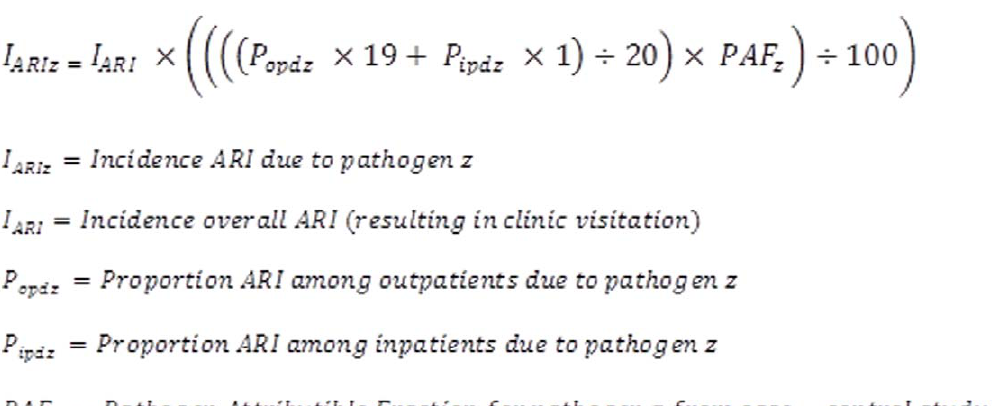
Figure 1. Equation to calculate incidence of ARI by etiology.